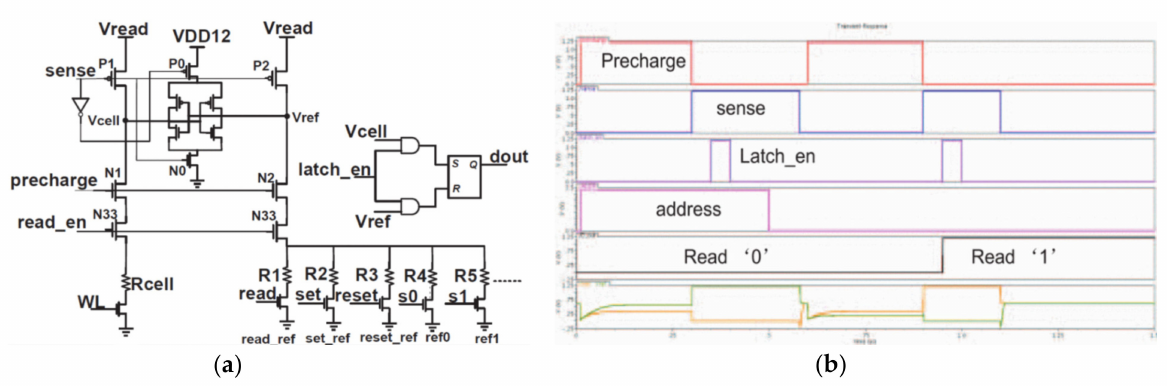
Figure 7. ( a ) Latch type sensitive amplifier; ( b ) operation waveform